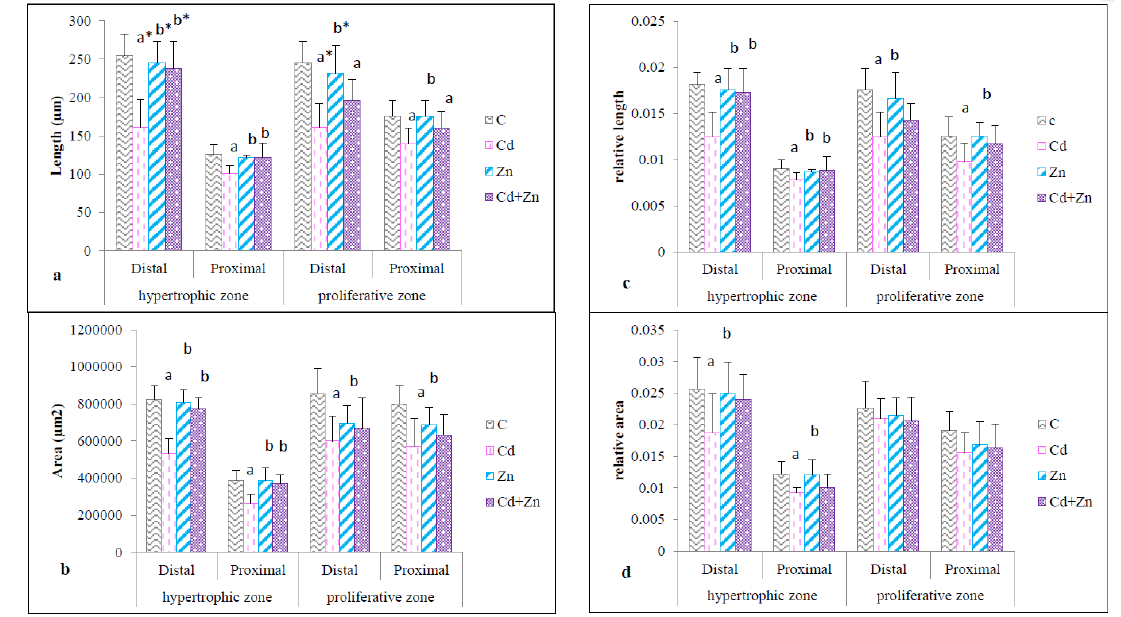
Figure 6. Length ( a ), area ( b ), relative length ( c ) and relative area ( d ) of the hypertrophic and proliferative zones of the femur of rat pups (PND21) from control females and pups from females exposed to cadmium (50 mg/L Cd as CdCl2) and / or zinc (60 mg/L Zn as ZnCl2) during gestation and lactation. Means ± SEM from six samples in each groups; a* (p < 0.01); a ( p < 0.05): significant difference compared to the control group (C); b* ( p < 0.01); b ( p < 0.05): significant difference compared to the Cd group (Cd).